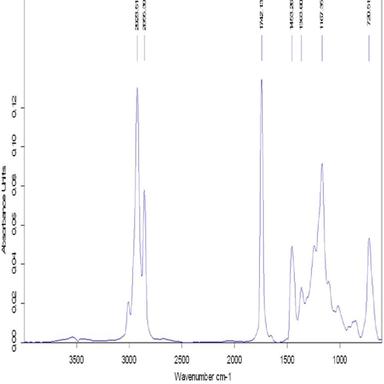
FT-IR Spectrum Showing Various Peaks in Peelu Crop Methyl Esters.